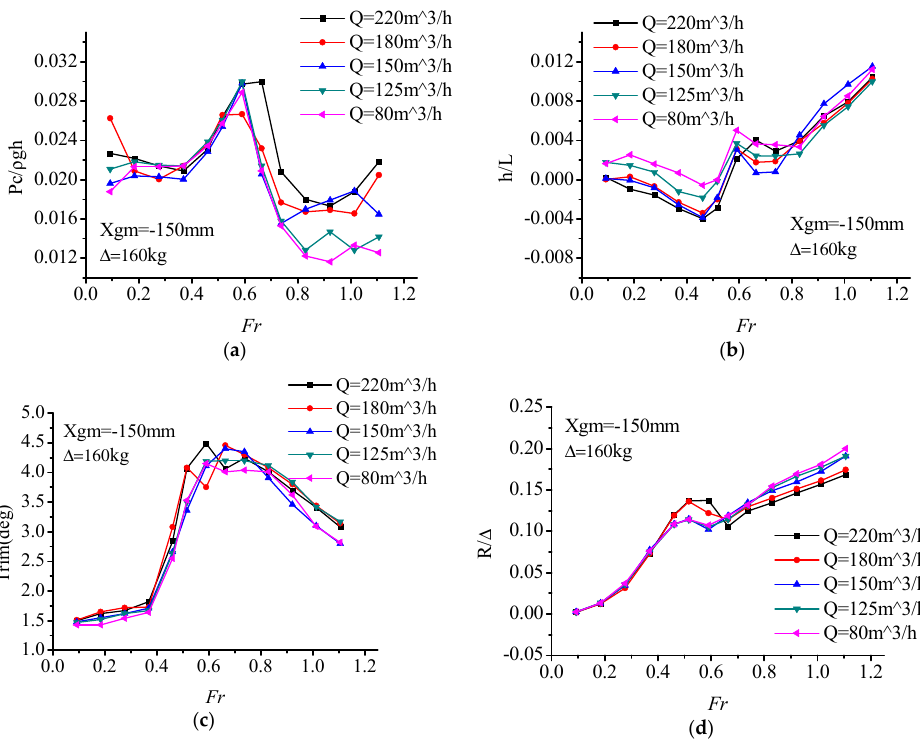
Figure 10. Comparisons of numerical and experimental results with consistent displacement Δ = 160 kg. ( a ) Curves of air cushion pressure; ( b ) Curves of air cushion heave; ( c ) Curves of trim angle; ( d ) Curves of total resistance.